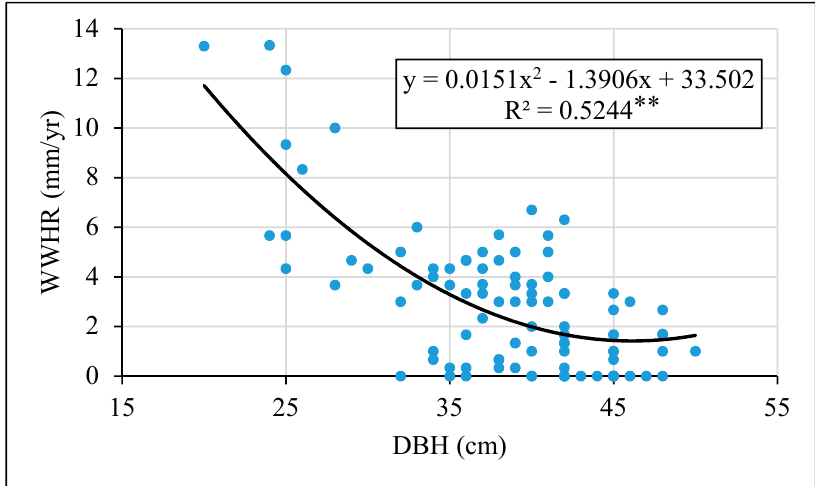
Figure 5. Relationship between wound width healing rate (WWHR) and tree dbh.